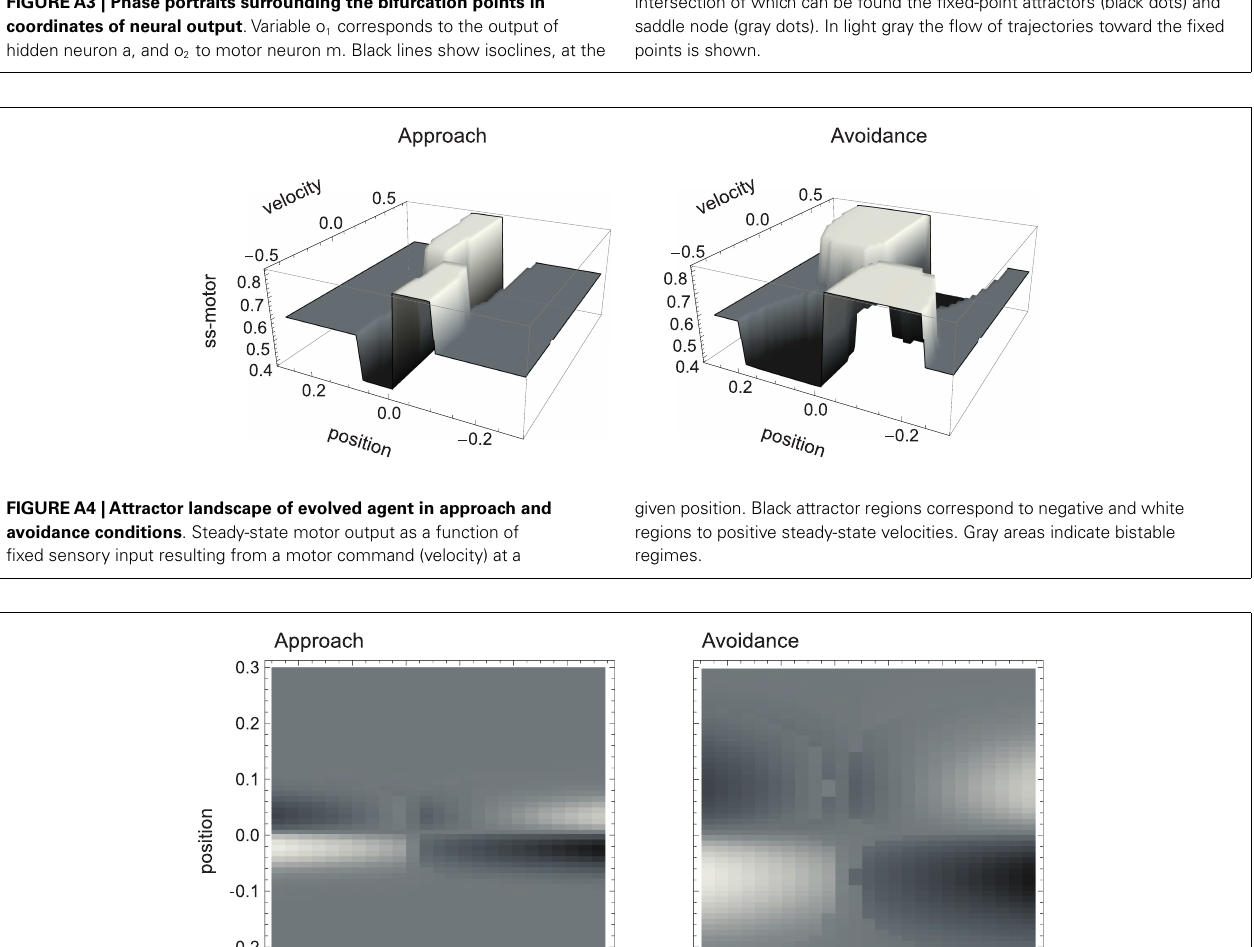
FIGUREA3 | Phase portraits surrounding the bifurcation points in coordinates of neural output .Variable o 1 corresponds to the output of hidden neuron a, and o 2 to motor neuron m. Black lines show isoclines, at the